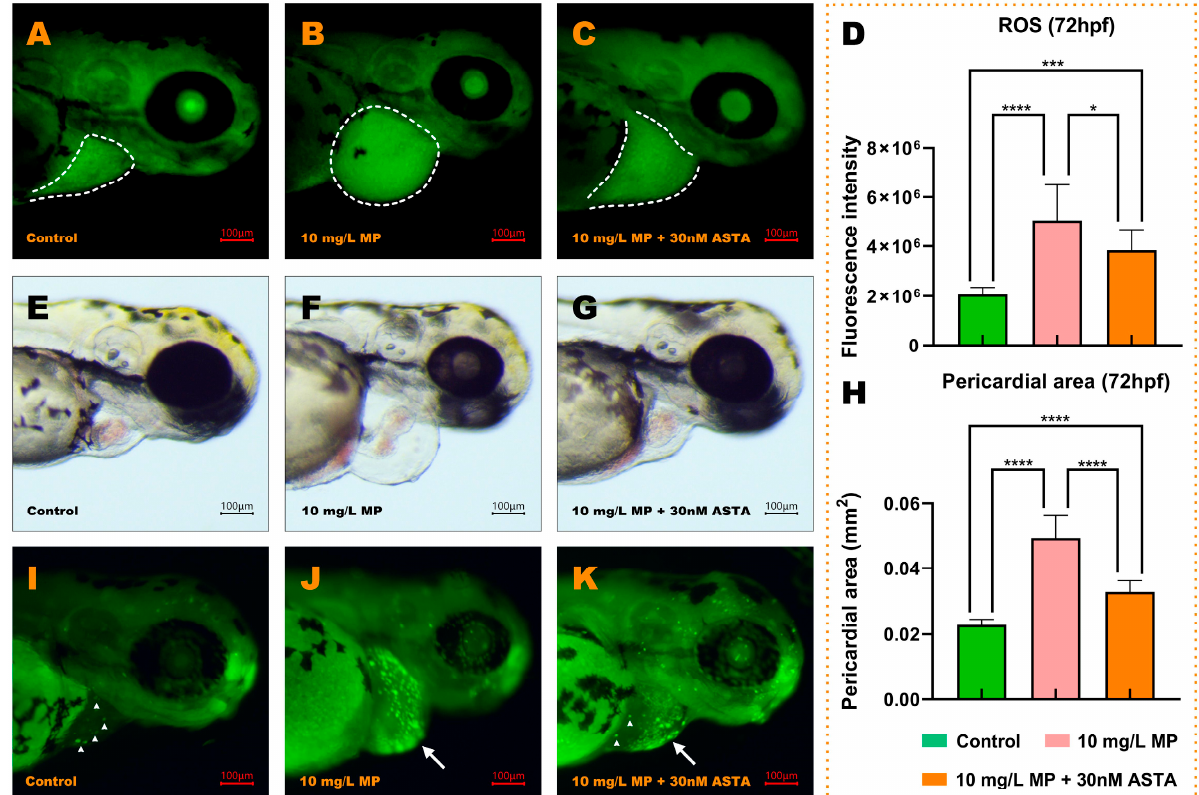
Figure 6. The heart morphological damage caused by MP was partially rescued by astaxanthin. ( A – C ) The fluorescence distribution of ROS in embryos is presented when exposed to E3, 10 mg/L MP, and the mixture of 10 mg/L MP and 30 nM astaxanthin, respectively. The white dashed area repre- sents the position of the heart after staining. ( D ) Relative fluorescence intensity of ROS. ( E – G ) Brightfield microscopy of embryos at 72 hpf. ( H ) Pericardial area. ( I – K ) When the embryos were subjected to three concentrations after AO staining, the apoptotic cells revealed yellow-green, fluo- rescent patches. The short, white arrows point to apoptotic cells, and the long, white arrows indicate a large number of dense apoptotic cells. (mean ± SD, n = 3, ANOVA, post hoc Dunnett’s multiple comparison test, * p < 0.05, *** p < 0.001, **** p < 0.0001).